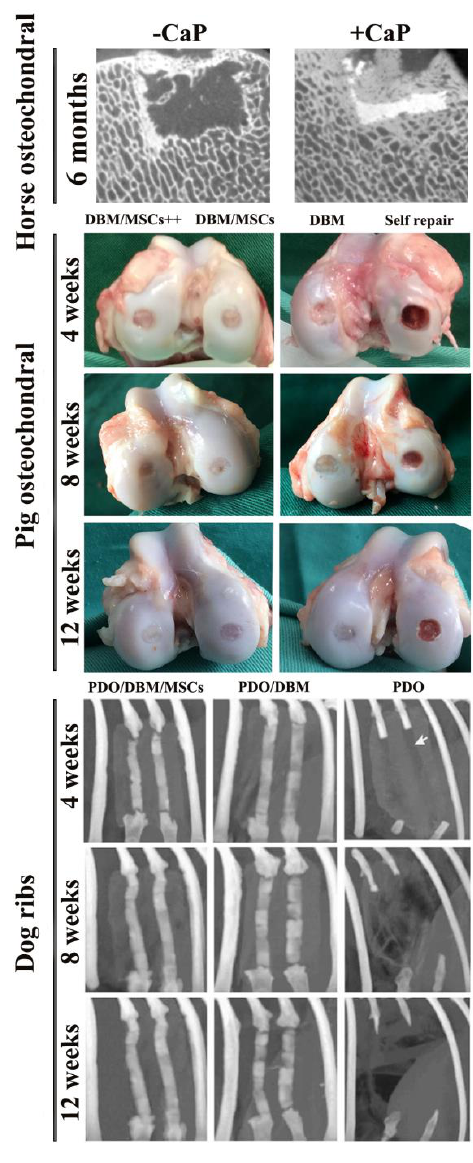
Figure 4. Repair and reconstruction of different natural bone grafts implanted in different sites in the rabbit bone defect model. Self repair, defect repair without any scaffold. MSCs, mesenchymal stem cells. –CaP, decellularized bone scaffold without calcium phosphate. +CaP, decellularized bone scaffold with calcium phosphate. DBM, demineralized bone matrix. PDO, polydioxanone. DBM/MSCs++, a combination of DBM and MSCs infected with adenovirus-mediated-bone morphogenetic protein (Ad-BMP-2) and transforming growth factor-β3 (Ad-TGF-β3). Reproduced with permission from [92]. Copyright Elsevier Inc, 2017. Reproduced with permission from [41].